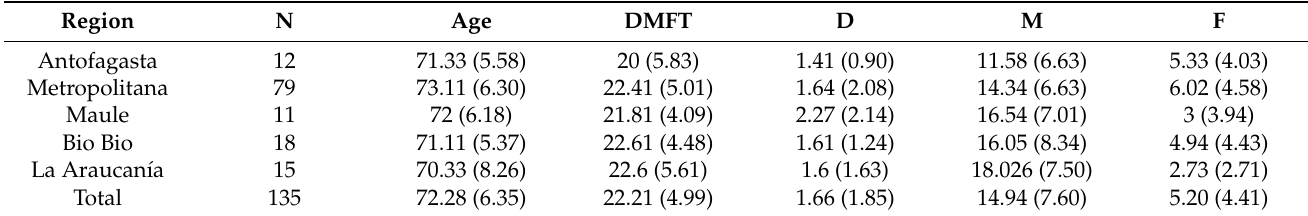
Table 4. DMFT index and its components (mean and SD) by Chilean